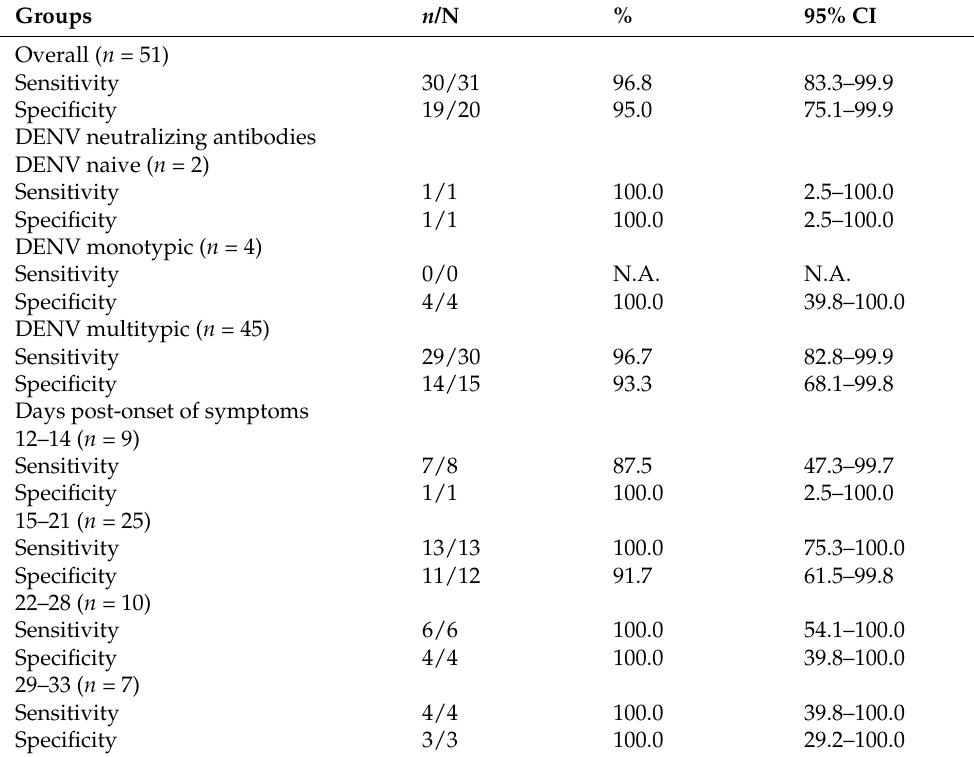
Table 3. PRNT performance for ZIKV